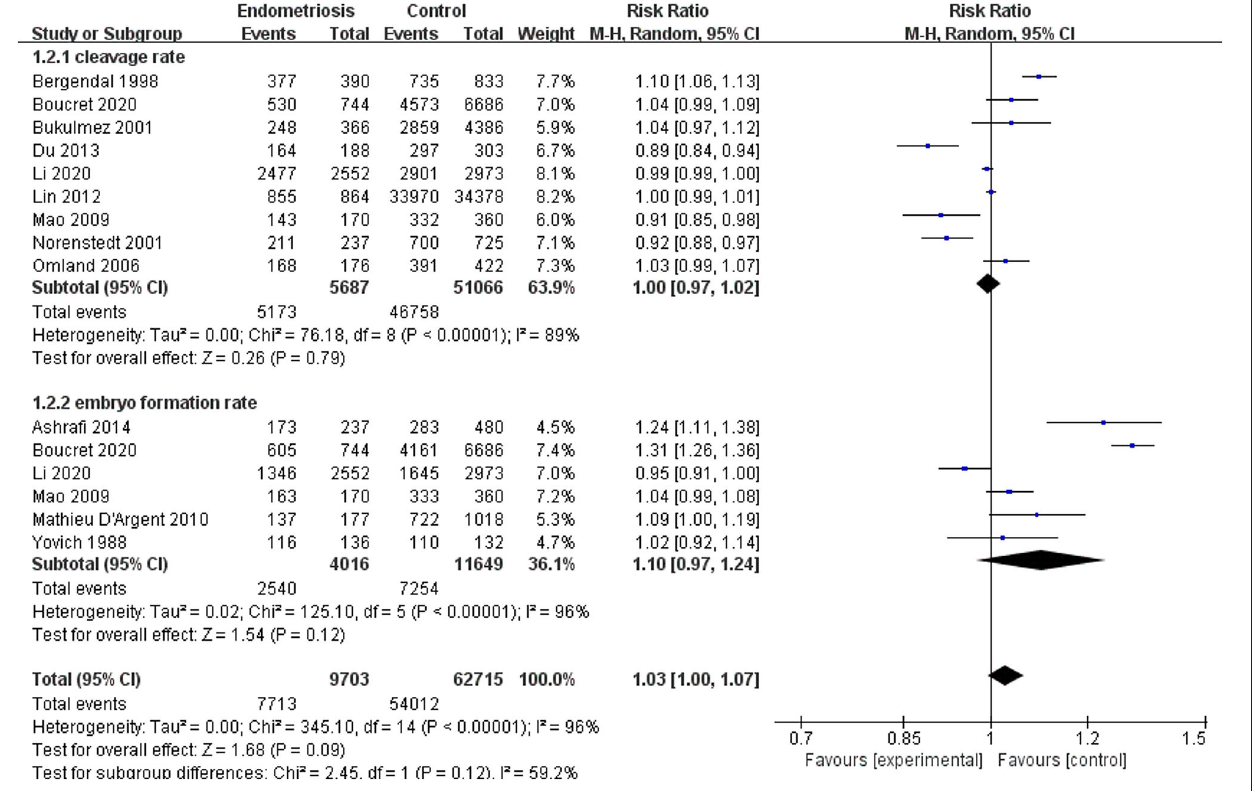
FIGURE 3 | Forest plot of cleavage rate and embryo formation rate for endometriosis vs.